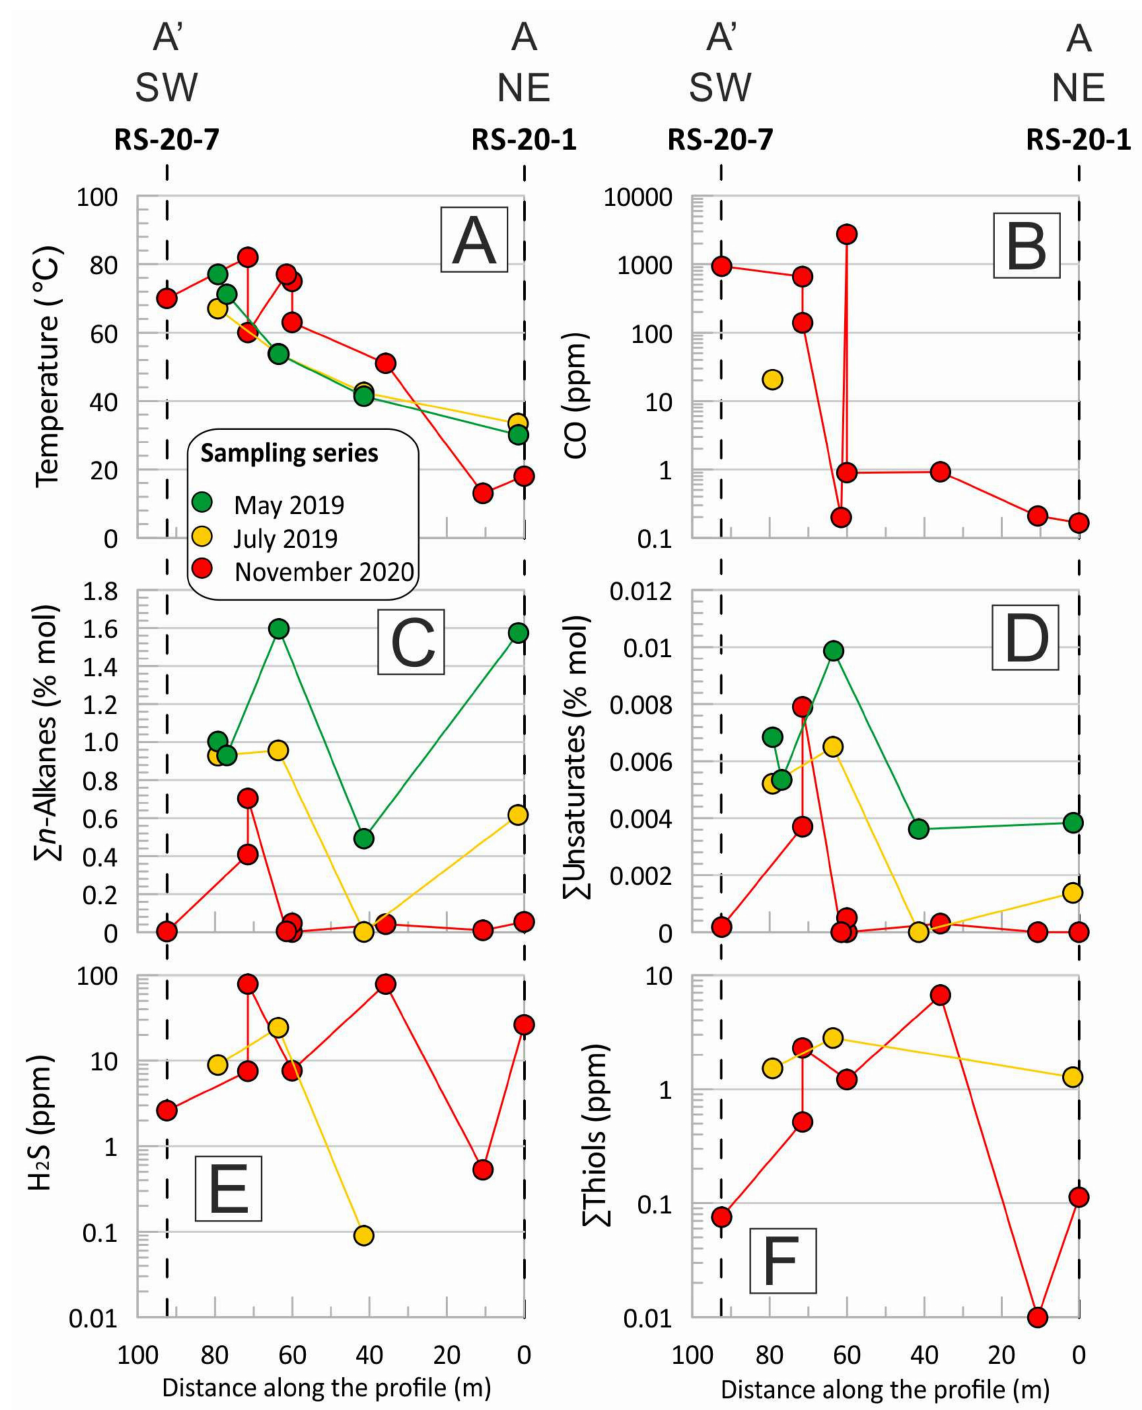
Figure 10. Changes of ( A ) temperature, and concentrations of ( B ) carbon oxide, ( C ) sum of n-alkanes, ( D ) sum of unsaturated hydrocarbons, ( E ) hydrogen sulphide and ( F ) sum of thiols of gases emitted from thermally active areas in the Rymer coal waste dump in the period from May 2019 to November